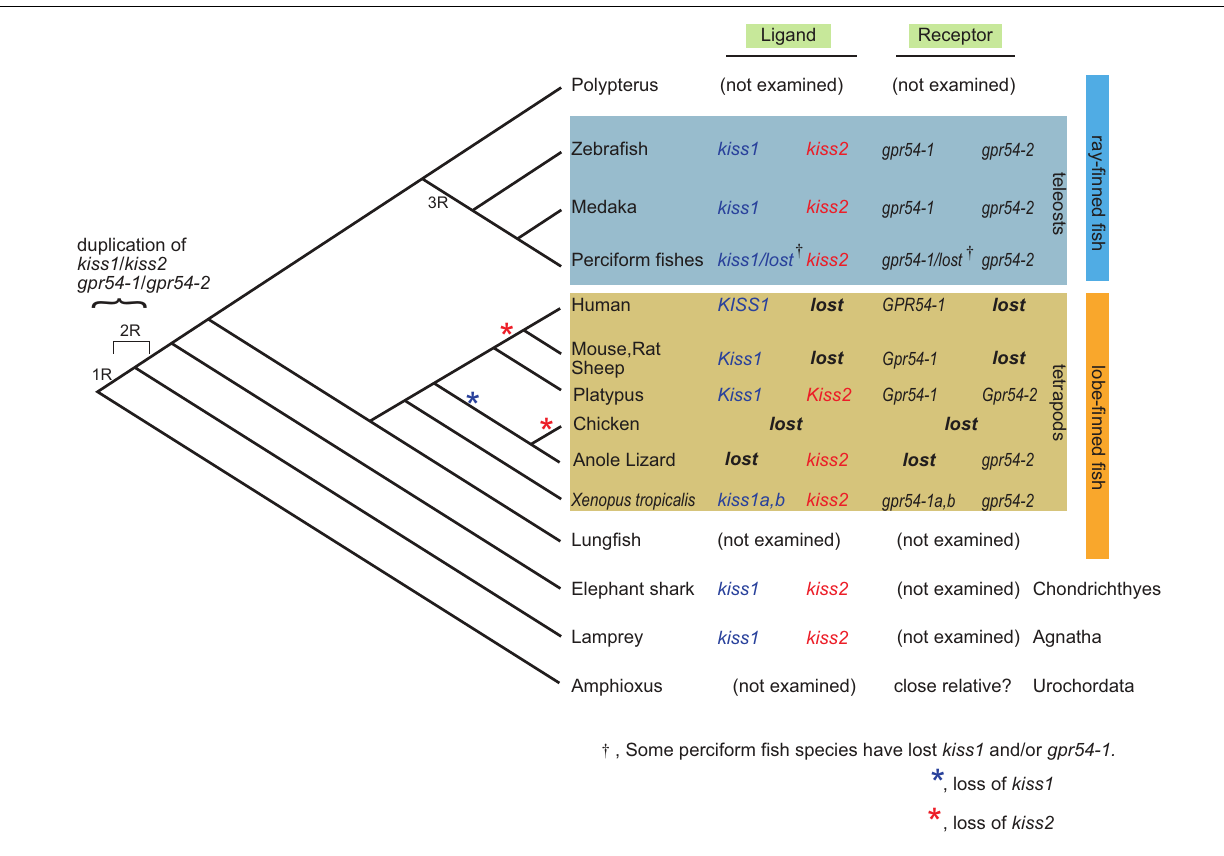
FIGURE 1 | Summary of the subtypes of ligand and receptor genes for kisspeptin systems in the genome along the vertebrate lineage. kiss1 and kiss2 are supposed to be duplicated before the emergence of lamprey, and probably due to the whole genome duplication of the ancestral vertebrate. It is supposed that kiss2 and gpr54-2 were lost in marsupial and placental mammals after the divergence from the monotreme during mammalian